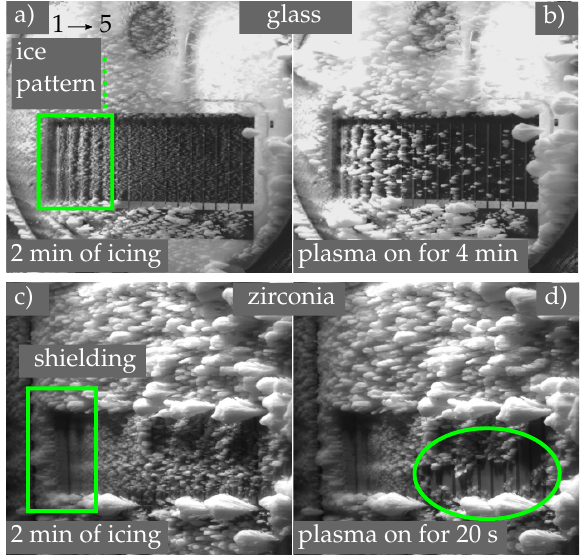
Figure 11. Images taken by the machine vision camera of the de-icing study with the glass and the zirconia SDBD. The SDBDs were turned off for 2min to ice the former active surface. Pictures ( b – d ) present the study after the de-icing time displayed in the lower left